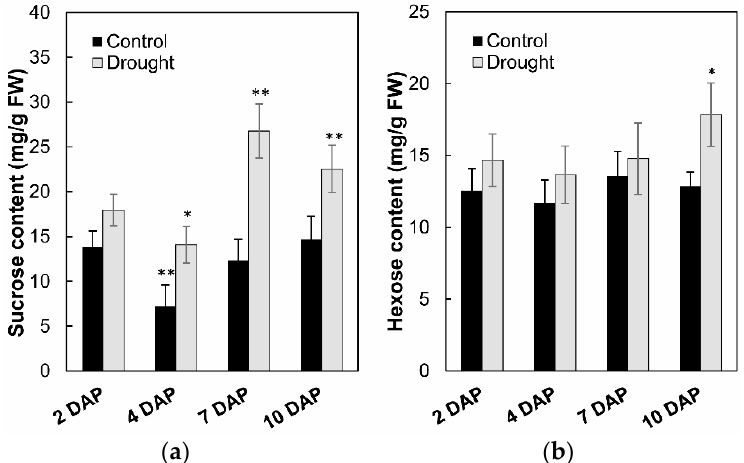
Figure 12. Effect of drought stress on sucrose content ( a ) and hexose content ( b ) in young maize kernels. Data of sugar quantification represents mean ± SE of at least six biological replicates. Asterisks indicate significant differences in comparison with the control using a Student’s t -test: * p < 0.05, ** p < 0.01. Additional transcript analysis of young kernel-expressed invertase-related genes was carried